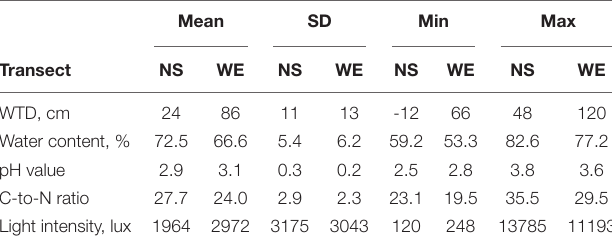
TABLE 1 | Summary statistics of the measured environmental variables along NS and WE